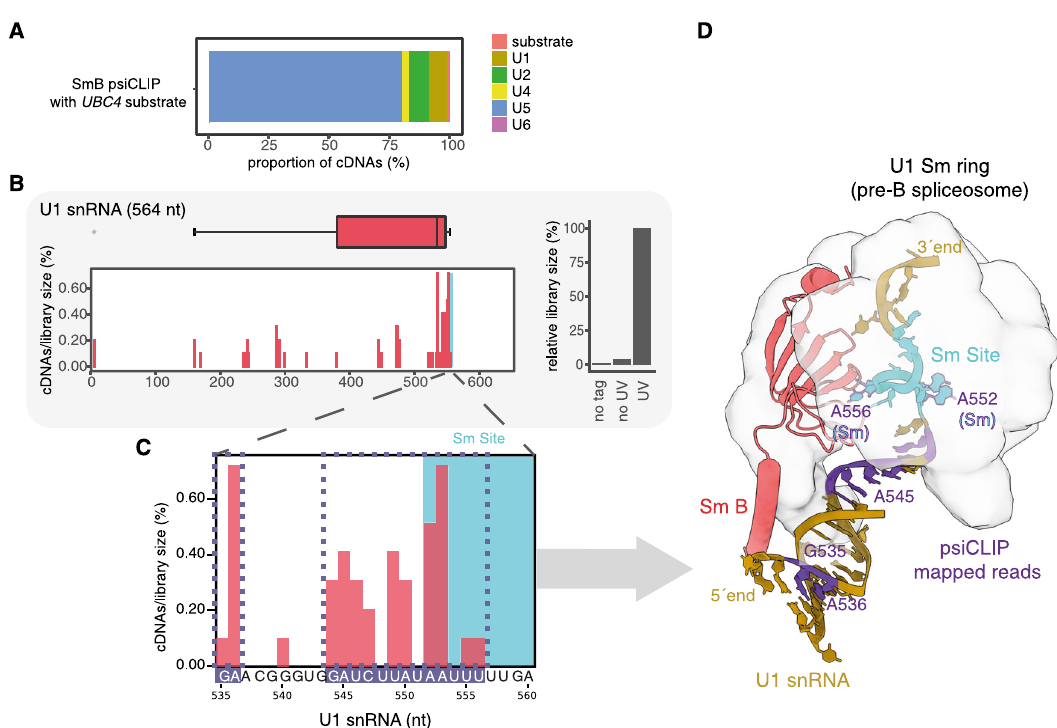
Fig. 2 Validation of the positional speci fi city of psiCLIP with SmB. A Proportion of cDNAs mapping to substrate and snRNAs for one SmB psiCLIP experiment on the short UBC4 substrate. B Crosslinking to U1 snRNA. Crosslink events ( − 1 position of cDNA start) are represented as a histogram and box plot aligned to the indicated snRNA. On the histogram, the y -axis indicates the proportion of cDNAs out of all cDNAs mapped to snRNAs and pre- mRNA substrate. The box plot represents crosslink positions from one sample along the transcript, weighted by normalized cDNA count. The line across the box represents the median; the lower and upper bounds correspond to the fi rst and third quartiles. The whiskers end at the largest and smallest value no further than 1.5 times the inter-quartile range. Outliers outside of this range are plotted as dots. The Sm site is highlighted in blue throughout. The bar chart represents the proportion of cDNAs in samples, normalized to the UV condition, which is shown as 100%. No tag: UV-irradiated untagged SmB, no UV: SmB-3× FLAG without UV irradiation, and UV: UV-irradiated SmB-3× FLAG. C Zoom in to show crosslinking speci fi cally at the Sm sequence element on U1 snRNA, which is highlighted with a blue background. The U1 snRNA region highlighted in purple is shown in D mapped onto the cryo-EM structure. D Structure of the U1 snRNP Sm ring in the spliceosomal complex pre-B (ref. 40 ; PDB: 5ZWN) with the SmB protein in salmon and the nucleotides of U1 snRNA in gold, with those showing the highest psiCLIP signal in purple or with a purple outline, corresponding to the purple boxes in C